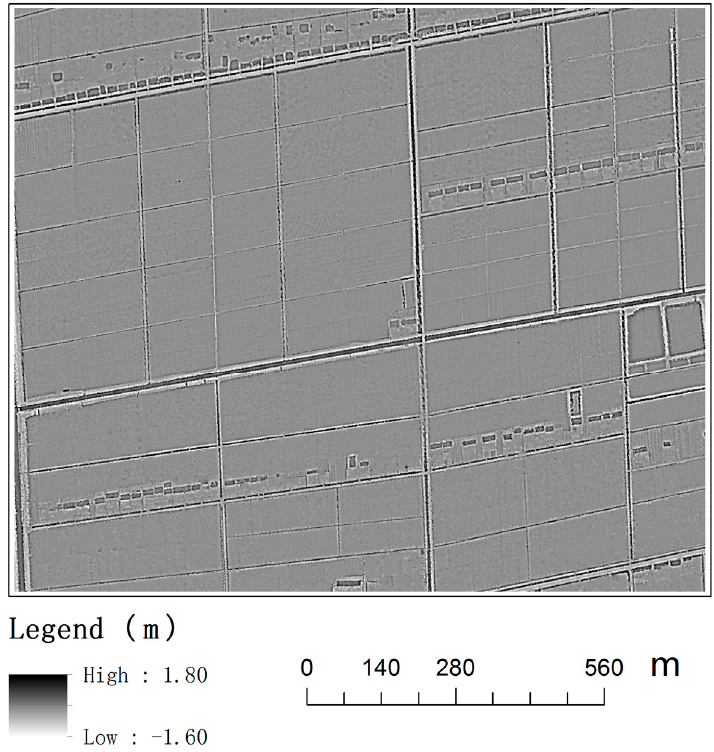
Figure 6. New surface generated by subtraction.